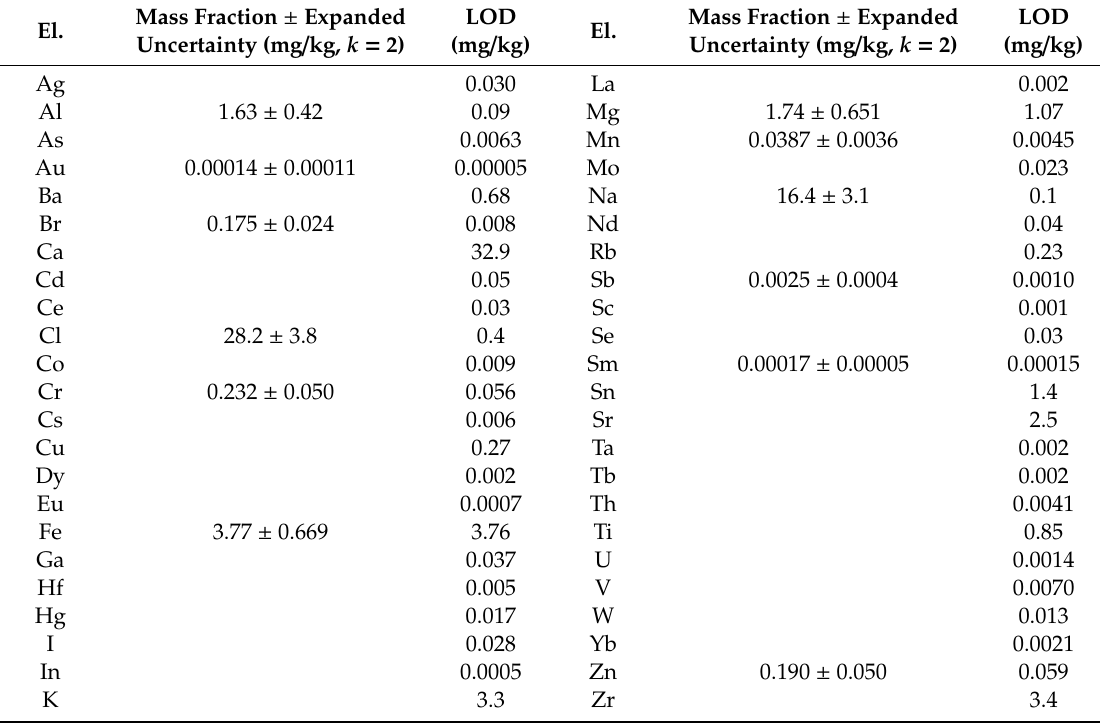
Table 1. Elemental mass fractions (above LODs) of cellulose paper analyzed by k 0 -INAA and their LODs.